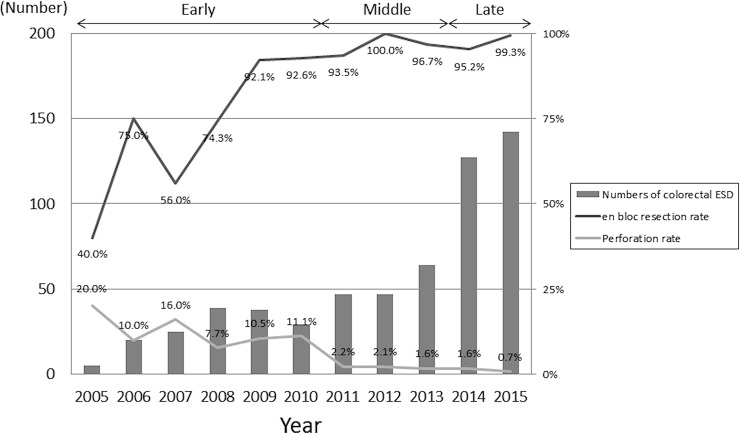
The differences in the numbers of colorectal ESDs, en bloc resection rate, and perforation rate.